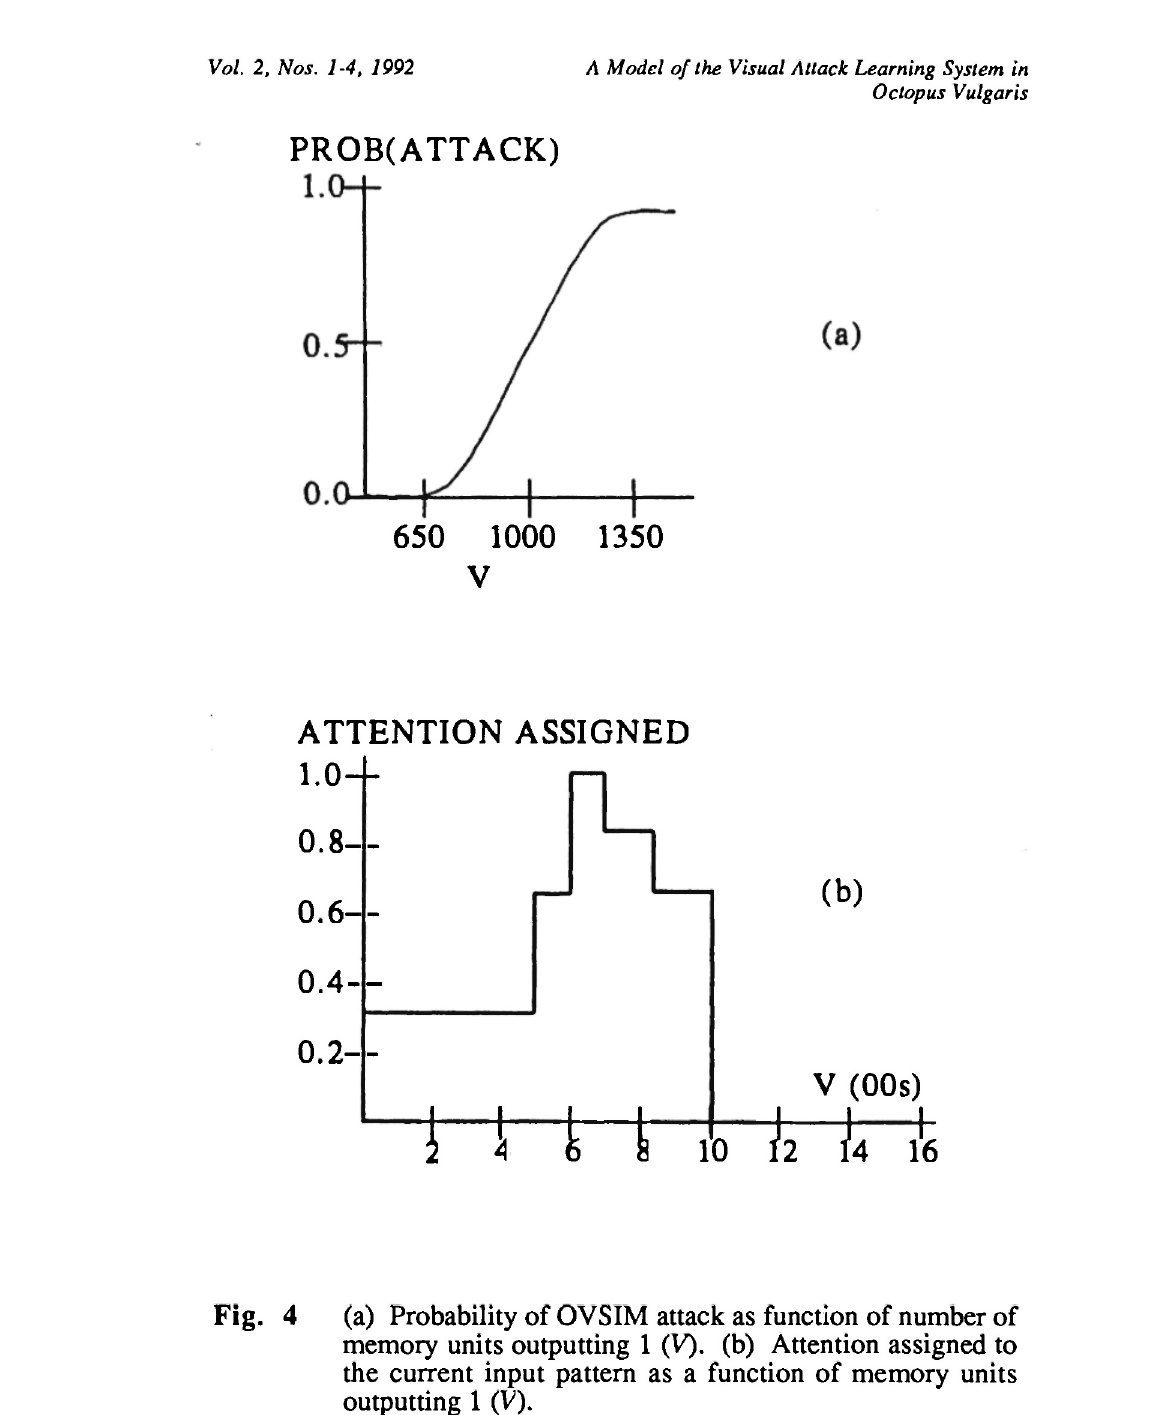
(a) Probability of OVSIM attack as function of number of memory units outputting 1 (V). (b) Attention assigned to the current input pattern as a function of memory units outputting 1